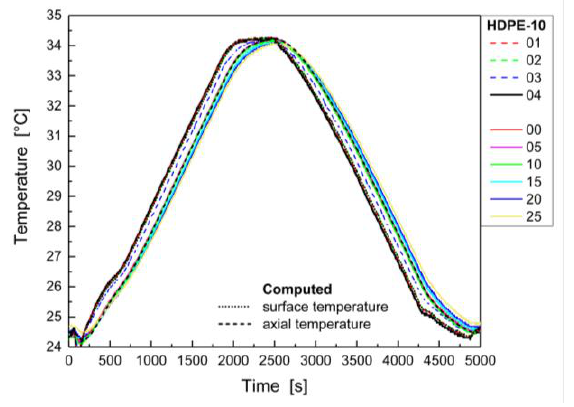
Figure 22. Time-history of measured temperatures and computed surface and axial temperatures (measurement B — temperature increase in climate chamber by 10 °C/probe 2).